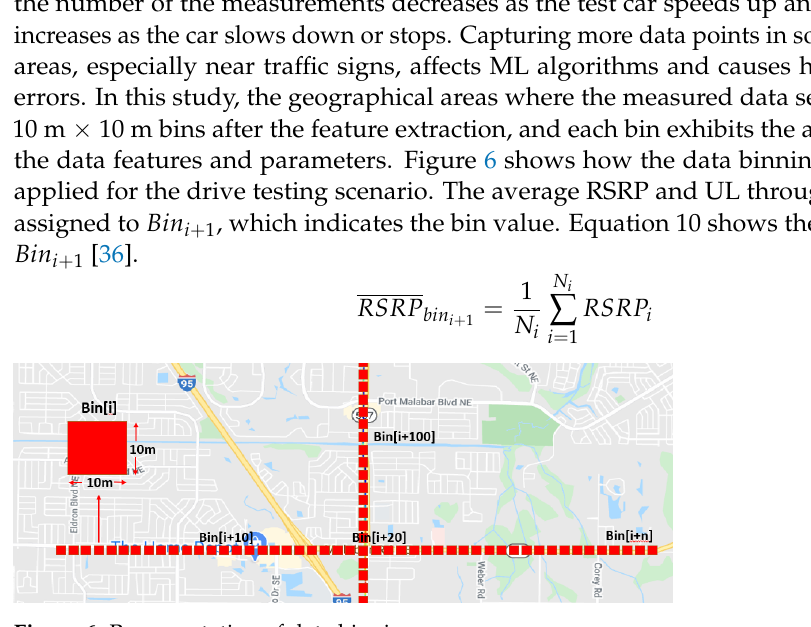
Figure 6. Representation of data